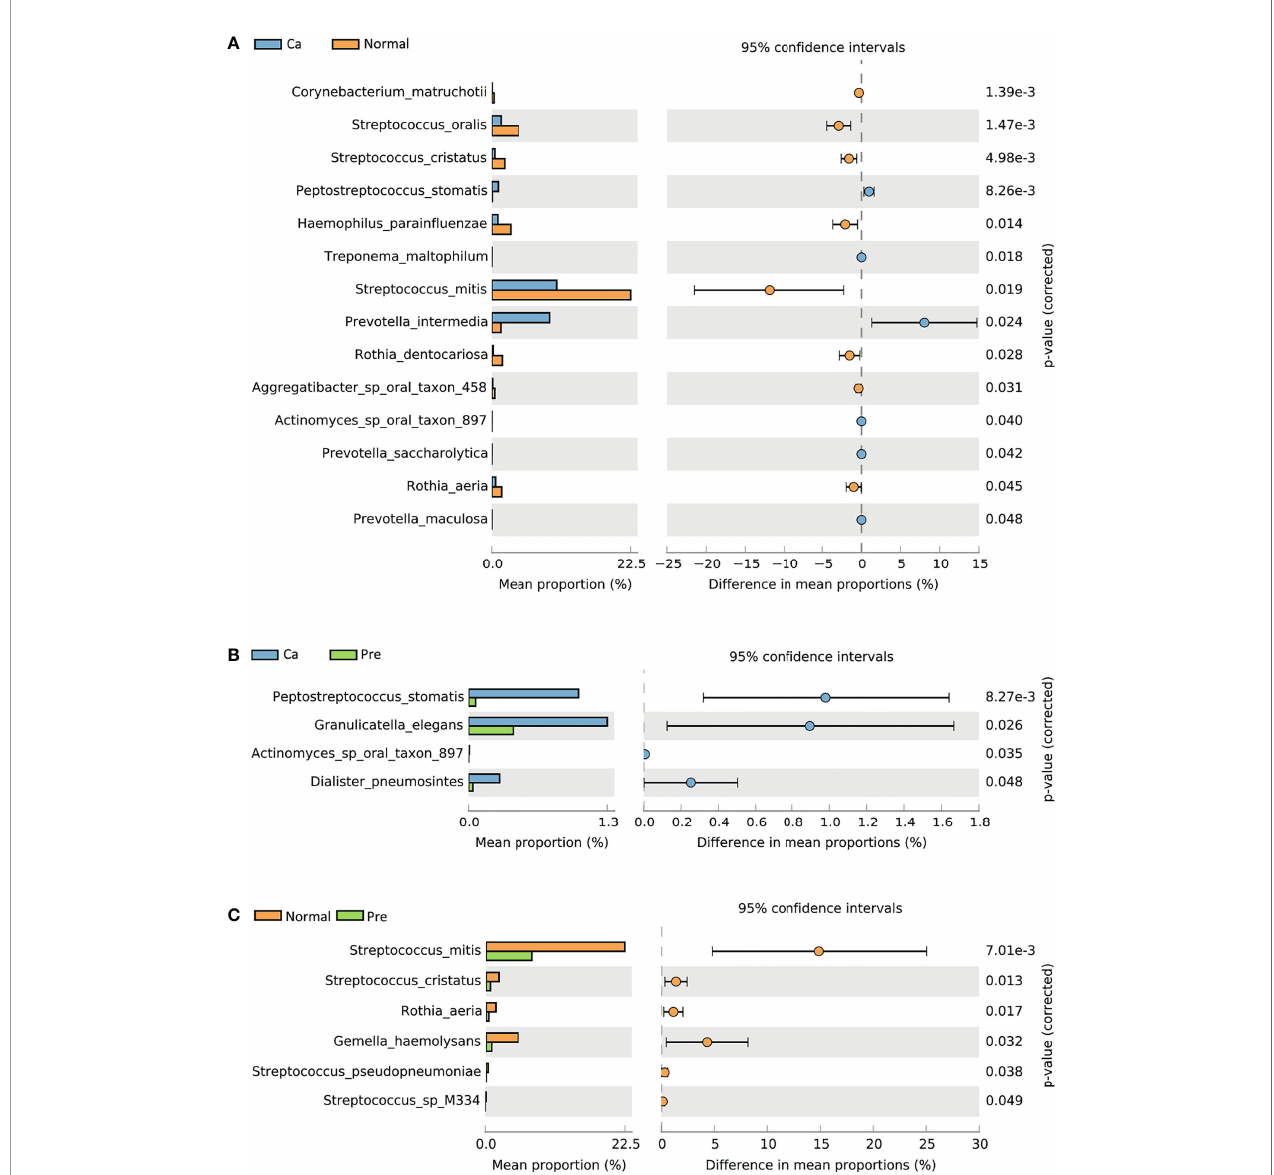
FIGURE 3 | Comparative taxonomic pro fi les at the species level showed signi fi cant differences in richness between two groups (P < 0.05, calculated using STAMP). (A) Difference between the oral cancer group and normal group. (B) Difference between the oral cancer group and precancerous lesion group. (C) Difference between the normal group and precancerous lesion